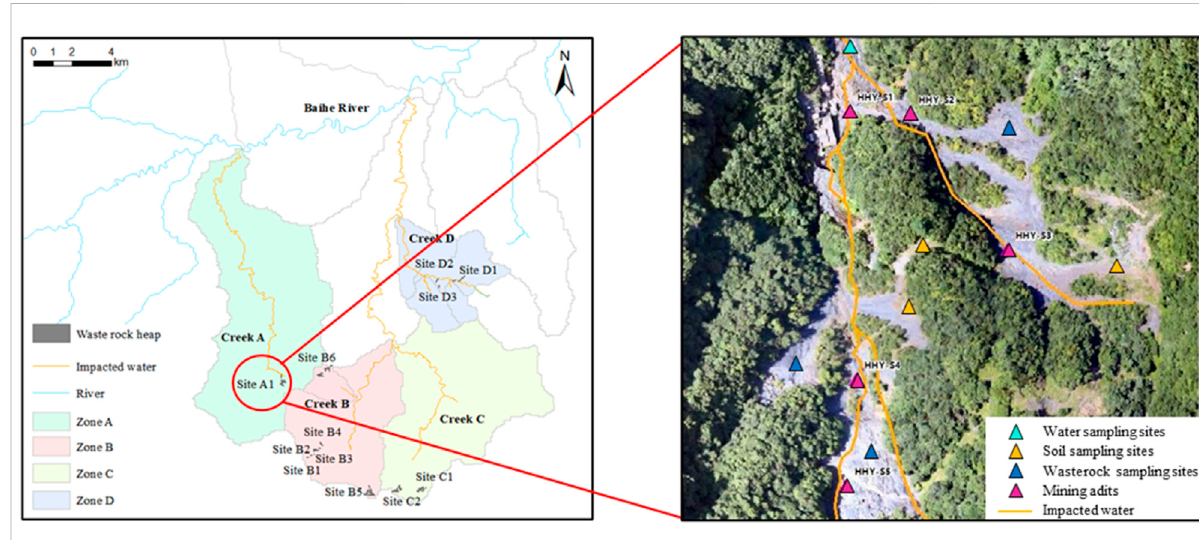
FIGURE 1 The layout of the abandoned pyrite mining area and the sampling locations in Site A1 > .